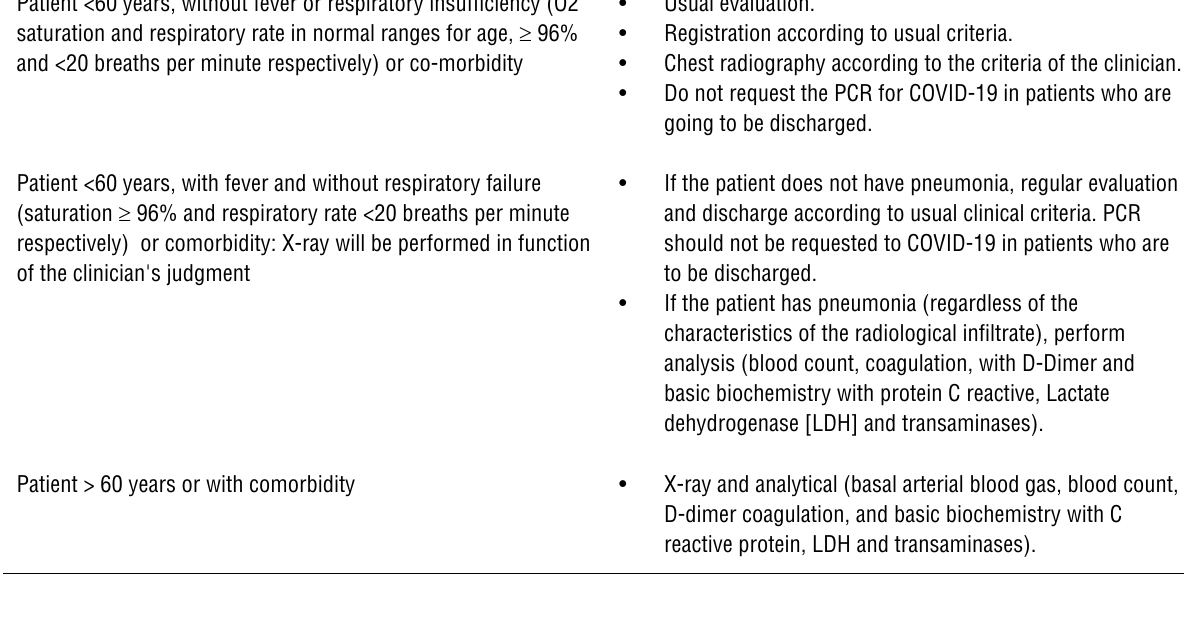
Table 4 - MSCBS. Discharge criteria in patients with Pneumonia due to COVID-19. April 2020 (8). Pneumonia may be discharged in patients <60 years, with Pneumonia Severity Index (PSI) I-II, without radiological complications or analytical complications, if they do not present hypertension and diabetes).